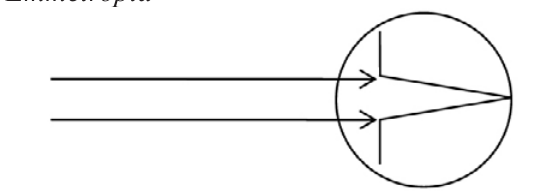
Figure 3. The emmetropic eye